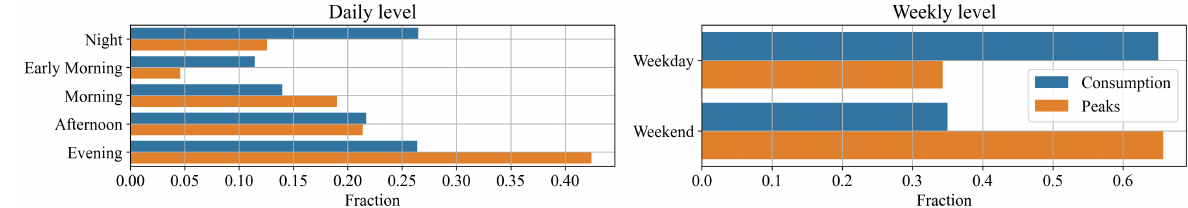
Figure 5. Example of the 14 features describing the temporal behavior of the consumption and peak demands at the daily and weekly level of household 802 in the